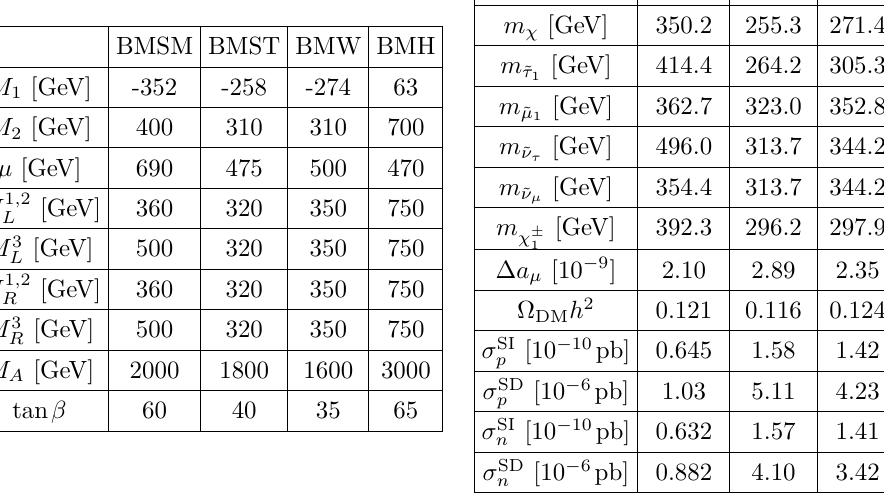
Table 1 . Values of the MSSM parameters, mass spectrum and quantities relevant for DM and ( g 2) for the case of Bino-like DM co-annihilating with light sleptons (BMSM), co-annihilating µ − with a light stau (BMST), co-annihilating with a Wino (BMW) and resonant s -channel annihilation via the SM-like Higgs boson (BMH). For BMH we also provide the mass of the SM-like Higgs boson m h between